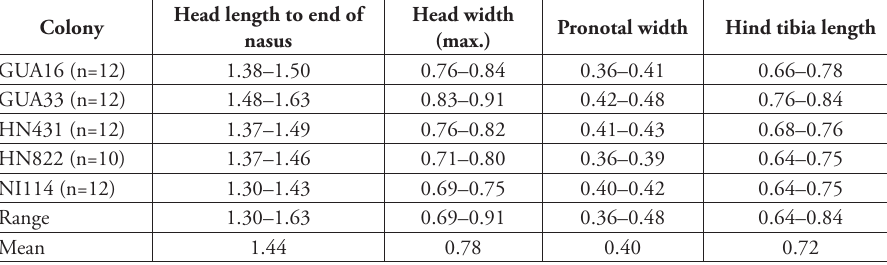
Table 3. Measurements (mm) of Parvitermes mesoamericanus sp. n. soldiers.